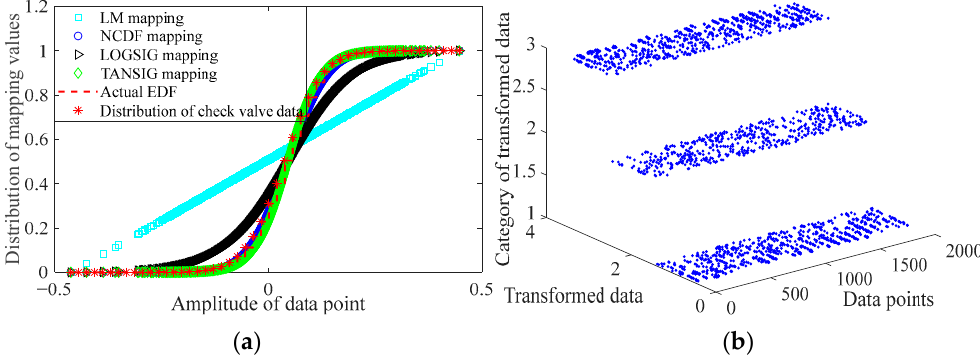
Figure 2. Comparison of mapping methods and classification of mapped data. ( a ) Comparison of different mapping methods; ( b ) data classification after TANSIG mapping.